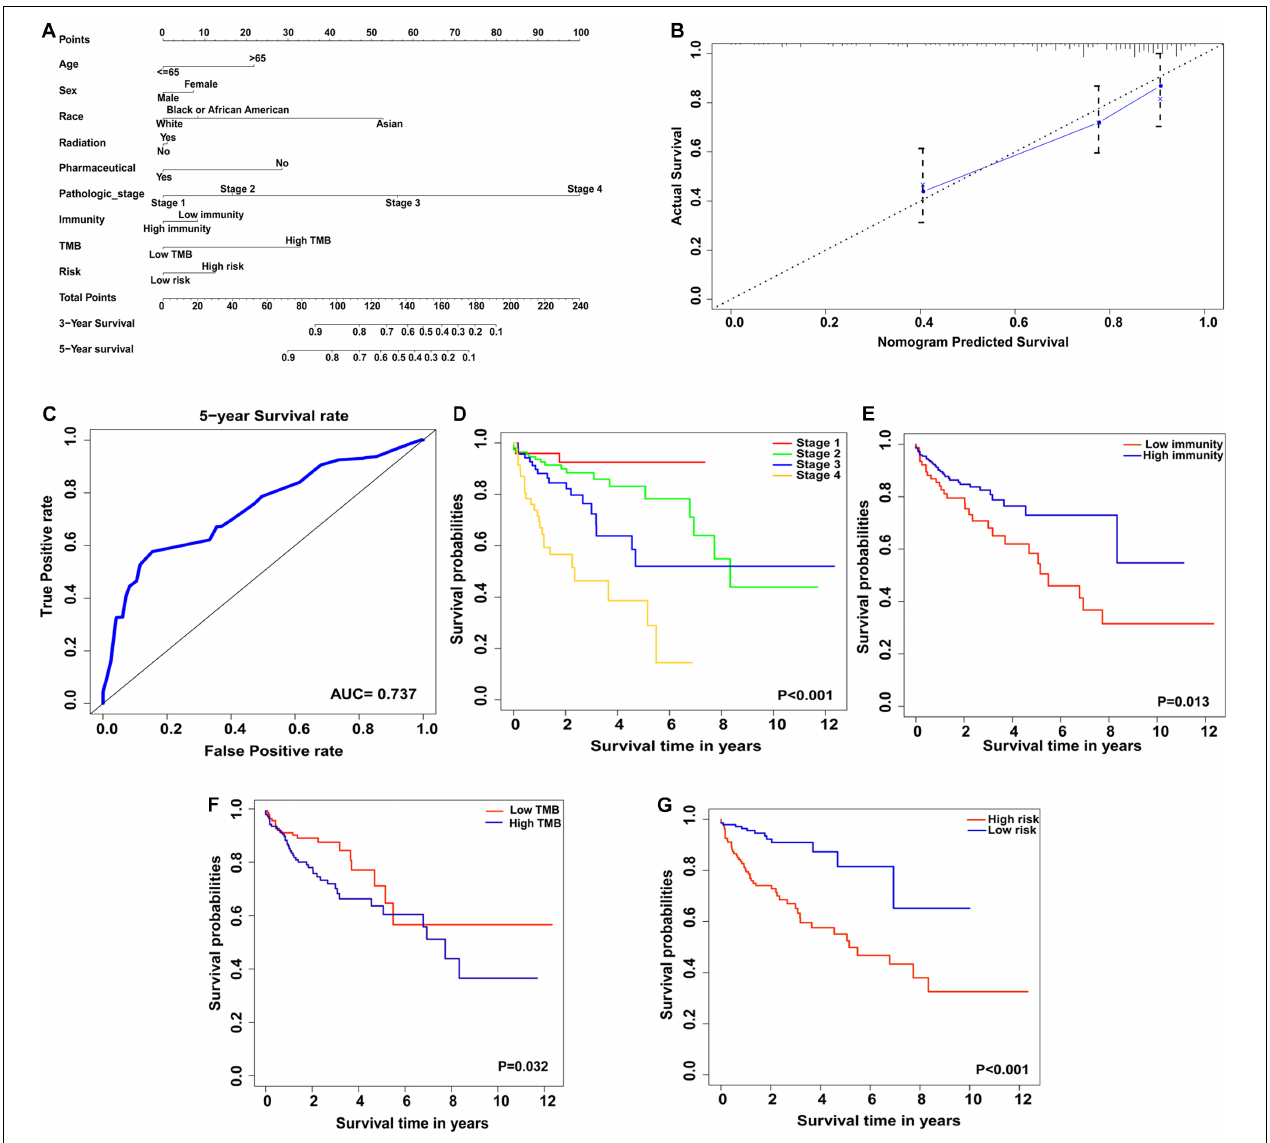
FIGURE 8 | Construction of nomogram model for prognosis prediction of colon cancer patients. (A) Nomogram model to predict the prognosis of colon cancer based on nine clinicopathological factors. (B) Calibration plot of the nomogram model. The dotted line represents the ideal prediction ability. (C) ROC curve of 5-year survival of colon cancer based on nomogram model prediction. (D–G) The clinical stages, immunity level, TMB level and immunity risk were significantly correlated with 5-year survival in nomogram